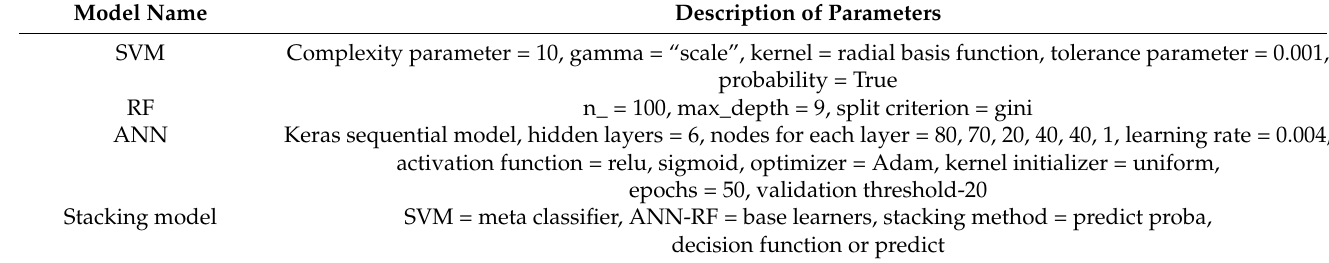
Table 1. Parameters of machine learning algorithms used for prediction of likelihood of GI transfor-